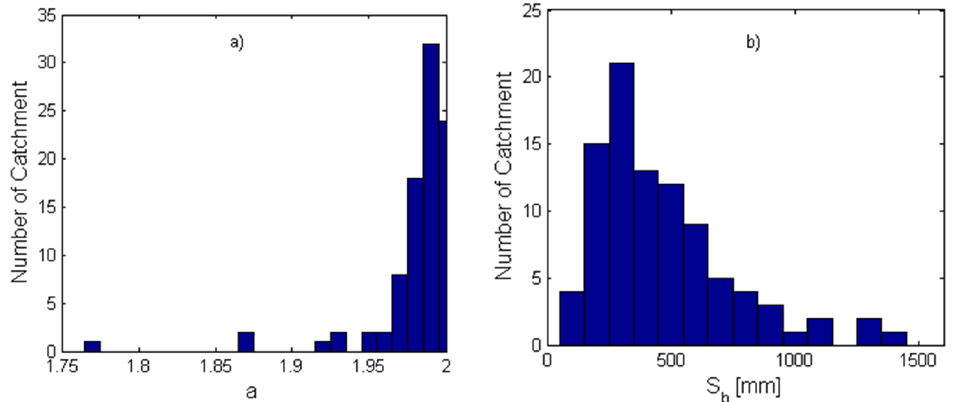
Figure 6. The frequency distribution of the calibrated parameters for the distribution function for soil water storage capacity: ( a ) the shape parameter ( a ); ( b ) the mean of the distribution ( S b ) . As shown in Table 1, the range for the shape parameter (a) is set to [0.01, 2.0]. However, the estimated parameters for all the catchments are greater than 1.75. That indicates that the CDF of the distributions is S-shaped [52]. For example, Figure 7 plots the CDF of the soil water storage capacity for the Nantahala River, located in North Carolina.